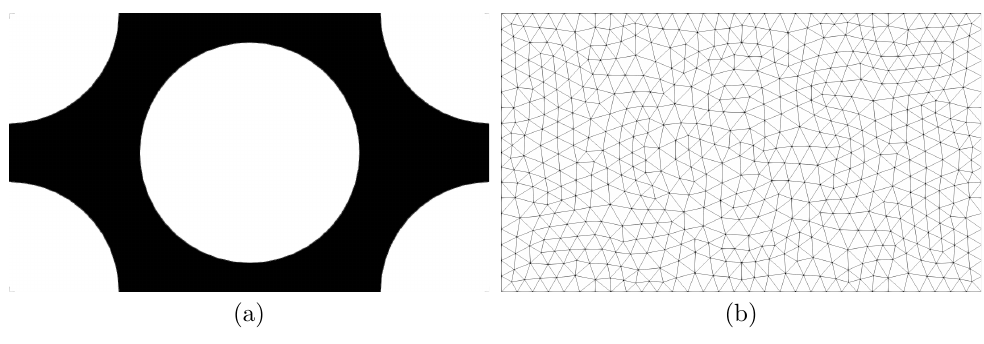
Figure 7. a) Periodic unit cell (PUC) with hexagonal arrangement of fibers in yarns, b) mesh of PUC.